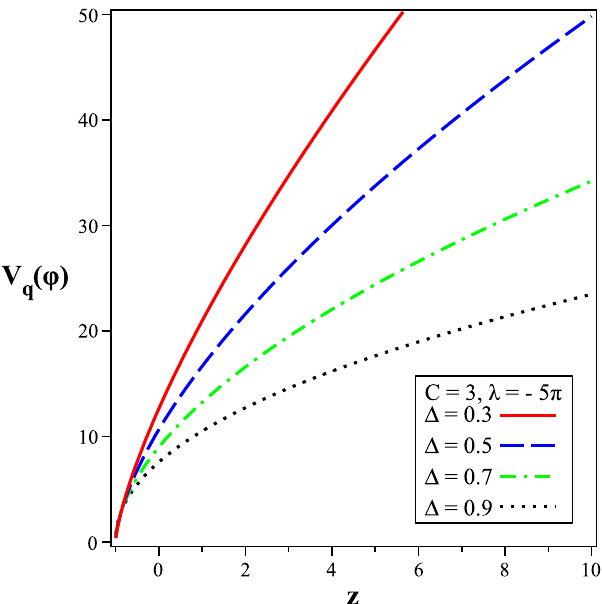
Figure 2. The plot of the Barrow holographic quintessence potential versus redshift ( z ); here, C = 3 and λ = − 5 π .